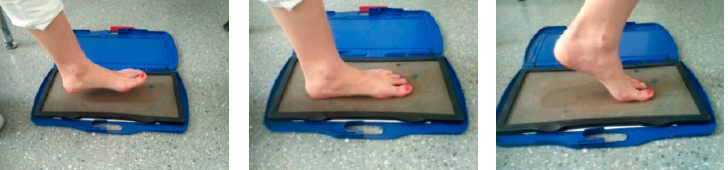
Figure 2. The patient walks on the ink footprint device to take the foot print. The progression of the step is shown during the standing phase. The other limb progresses from back to forward.